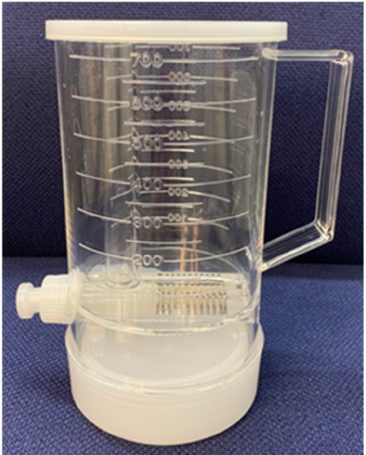
Figure 2. An aliquot cup that allows one-40th of urine samples to be collected personally at each time of voiding during 24-h urine sampling [39,43].